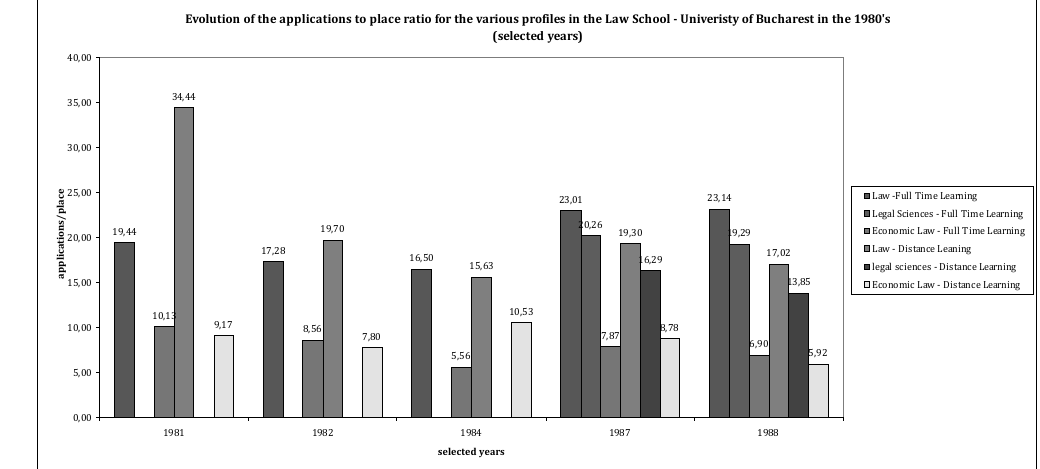
Figure 1. Evolution of the applications to place for various pro (cid:222) les in the Law School – University of Bucharest in the 1980`s (selected